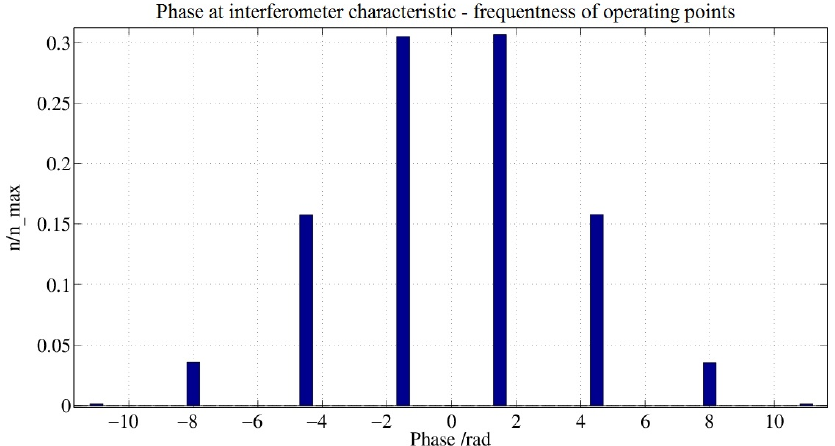
Figure 17. Frequency distribution of operating points with mean-value-free 4π-modulation.